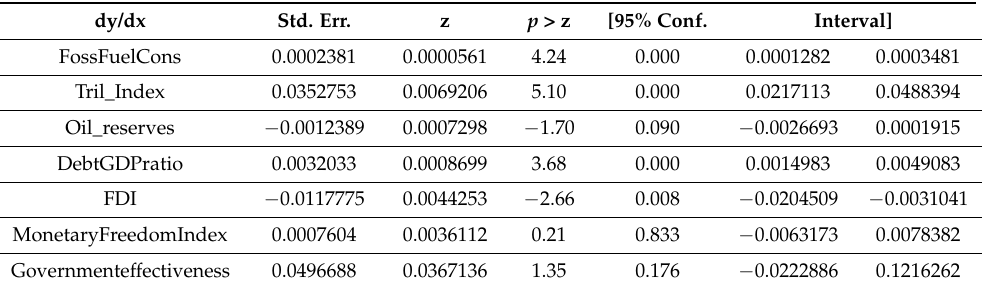
Table 6. Marginal effects after probit (Model